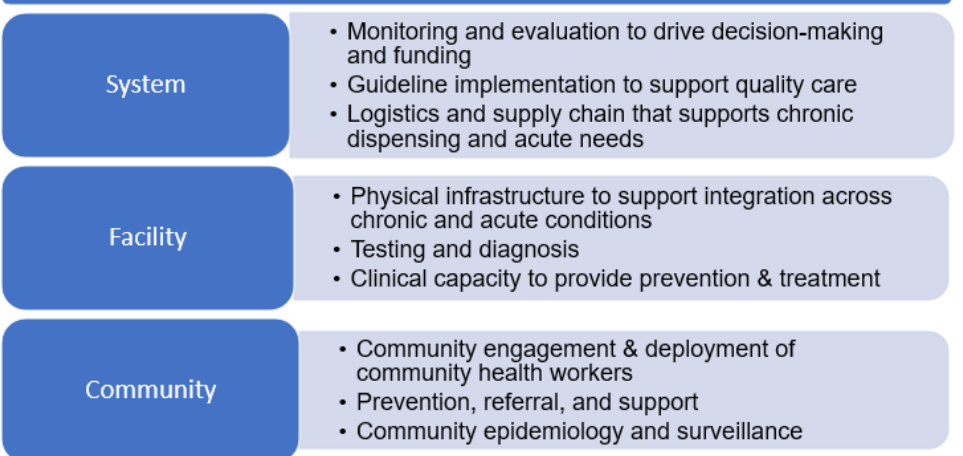
Figure 1. An overview of needs for communicable and non-communicable diseases that could be met with integration across levels of the healthcare system.